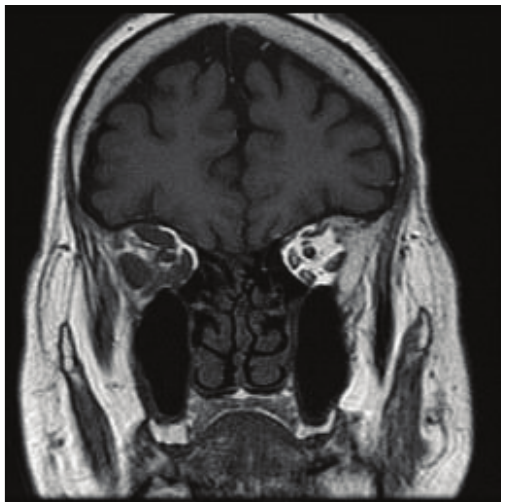
Figure 1: Coronal T1 MRI demonstrating enlargement of all of the extraocular muscles of the right orbit.